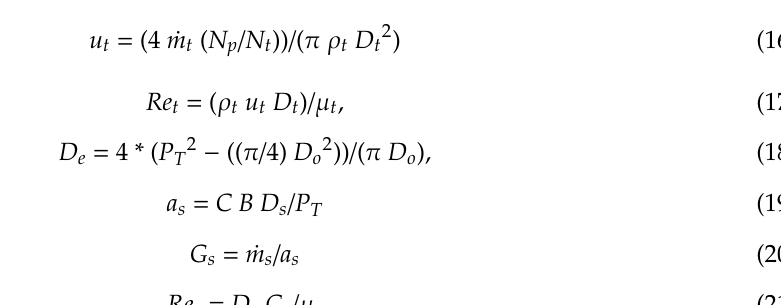
Table 2. The assumed overall geometric parameters for the shell and tube heat exchanger. Geometrical Parameters Symbol Value Unit Internal Tube Diameter D t 0.019 N t Number of Tube Passes N p P T 0.238 C 0.005 Ba ffl e Spacing B 0.305